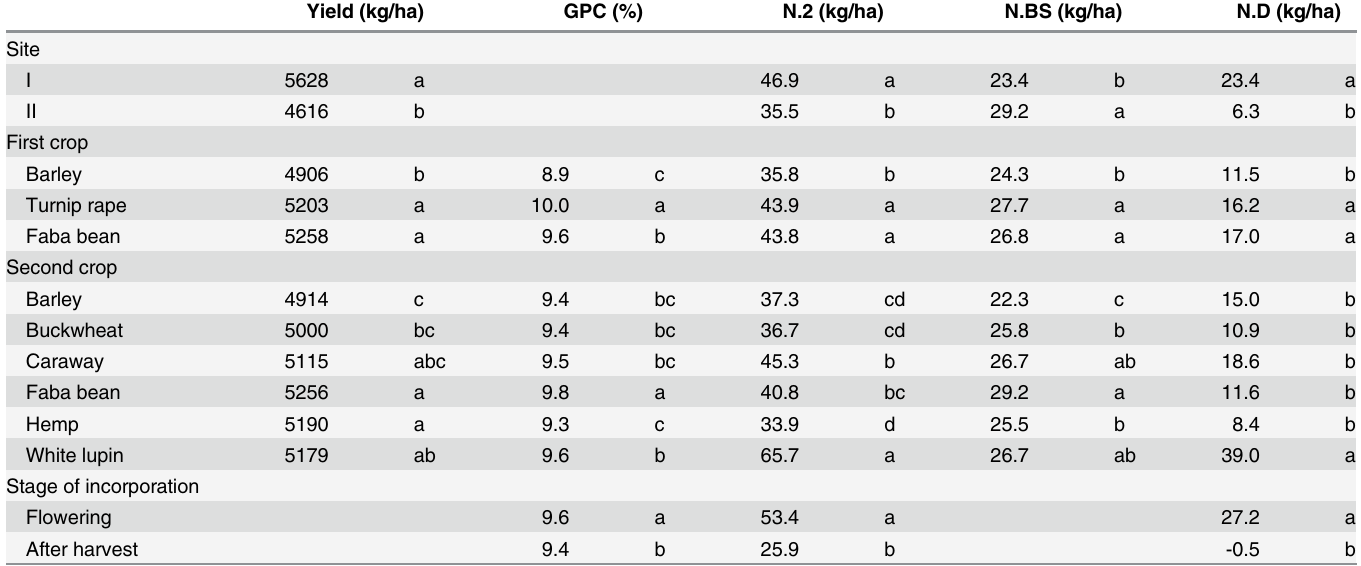
Table 3. Barley yields, GPC, mineral nitrogen concentration two months after incorporation of plant materials (N.2), before sowing the barley crop (N.BS), and difference (N.D) between N.2 and N.BS, as affected by site, first crop, second crop, and stage of incorporation of second-crop residues. Data show main effect